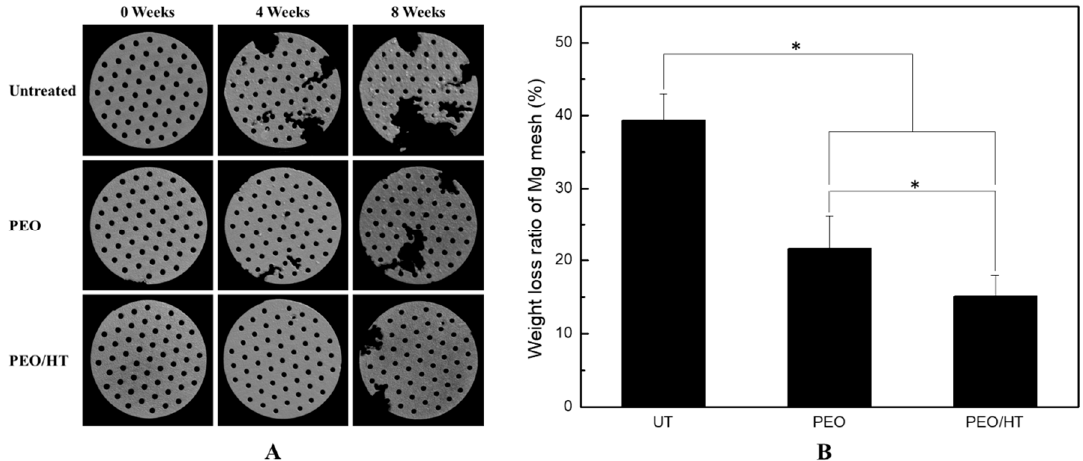
Figure 4. ( A ) 3D reconstruction for the Mg meshes after immersion in SBF for four and eight weeks, and ( B ) the weight loss ratio of the Mg meshes after immersion in SBF for eight weeks. (* means p < 0.05).